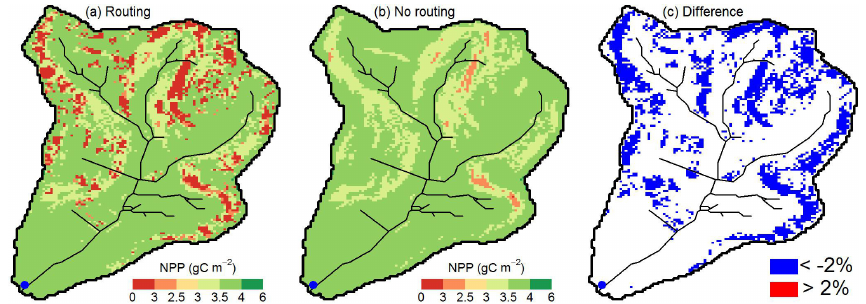
Fig. 5. Comparison of simulated monthly average daily net primary productivity (NPP) in July 1994 between the two simulations: (a) consid- ering water routing and (b) ignoring water routing. (c) Shows percentage difference between (a) and (b) divided by the result from simulation (a) considering water routing. The white areas show no significant